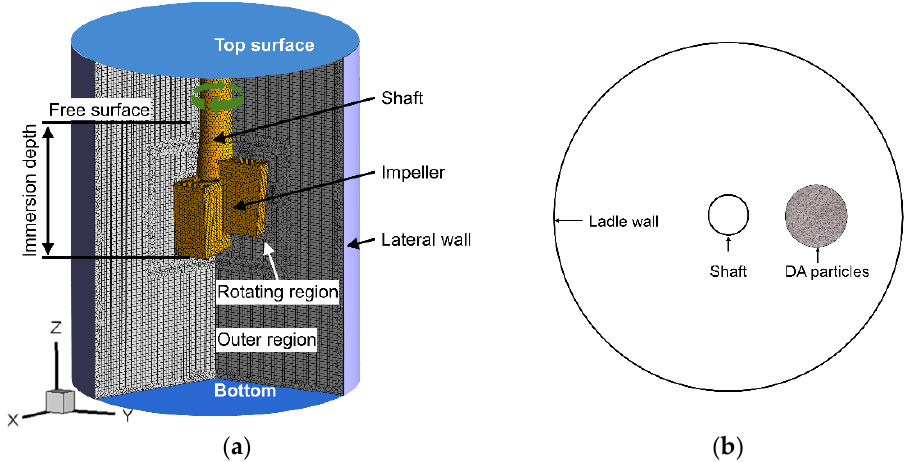
Figure 2. Schematic diagram of physical model. ( a ) Schematic diagram of the physical model and mesh; ( b ) DA particle release position.